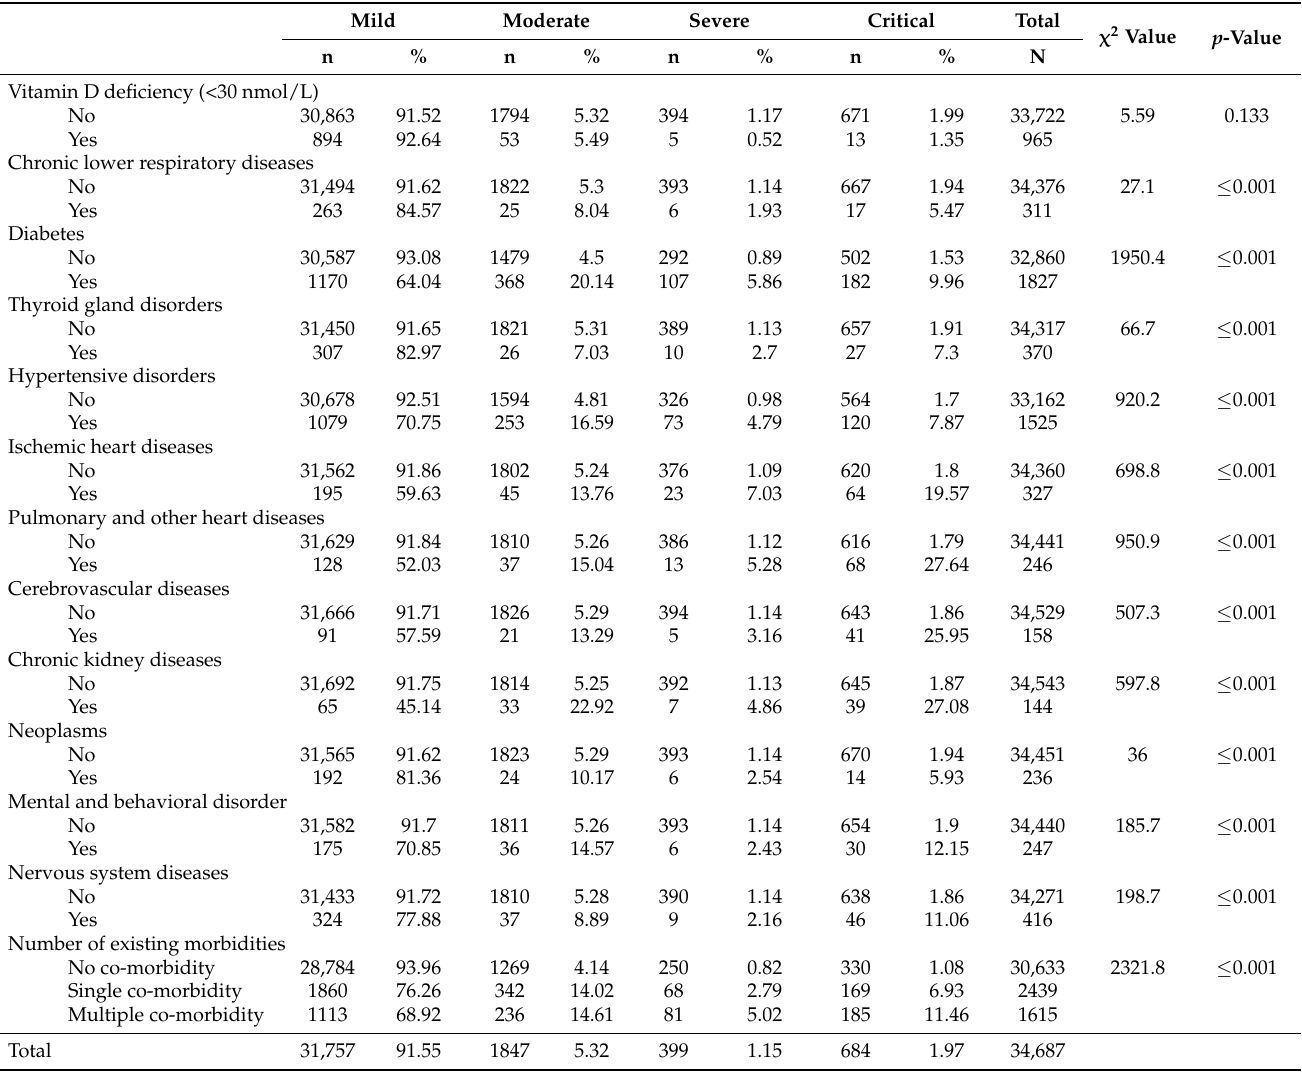
The Chi-square test for association between comorbidities and COVID-19 severity for the 4220 patients included in the multivariable regression analysis are displayed in Table A2. Table 3 presents results from the multivariable logistic regression analysis. Among the three regression models, the Pseudo R2 values according to (McFadden estimates) were 0.062 for model one, 0.087 for model two, and 0.090 for model three, respectively, indicating that model three provided the best goodness of fit to the